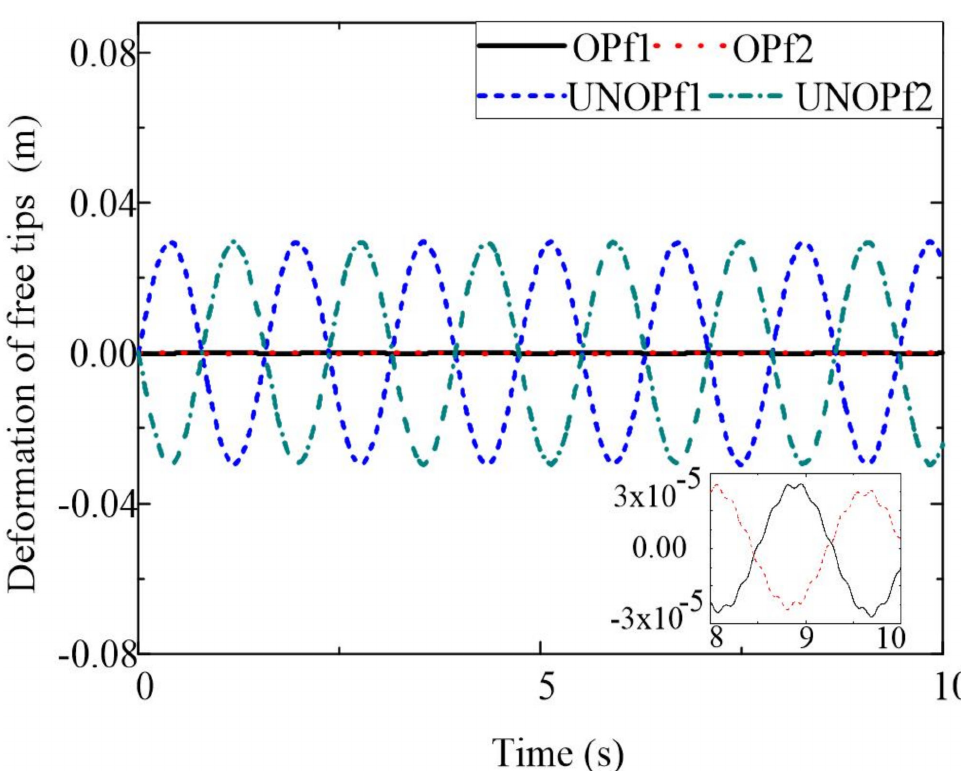
Figure 23. Deformation of the tips of the beams during the trajectory tracking